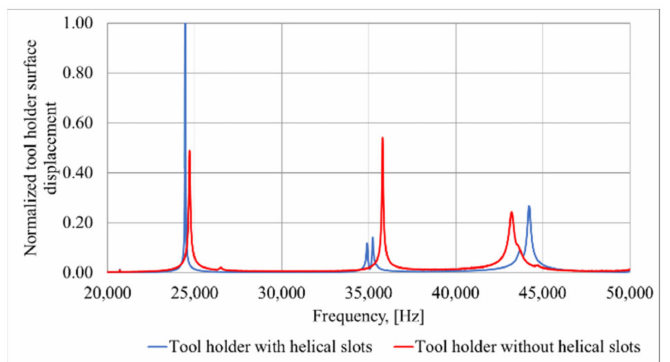
Figure 12. Measured surface displacement amplitudes for the tool holder with and without helical slots excited at axial mode.